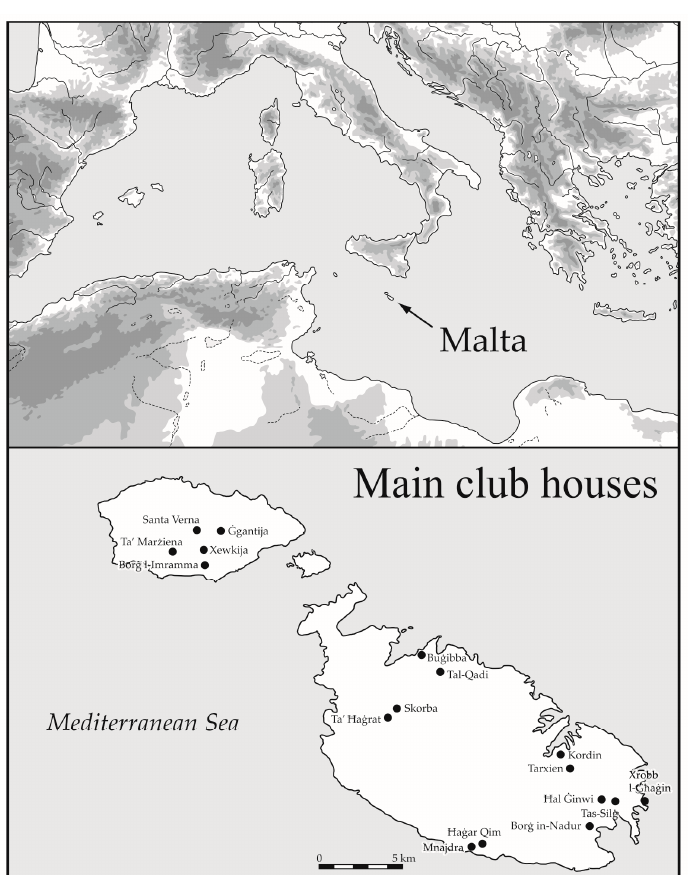
Figure 1. The Maltese islands. The location of club houses, traditionally known as